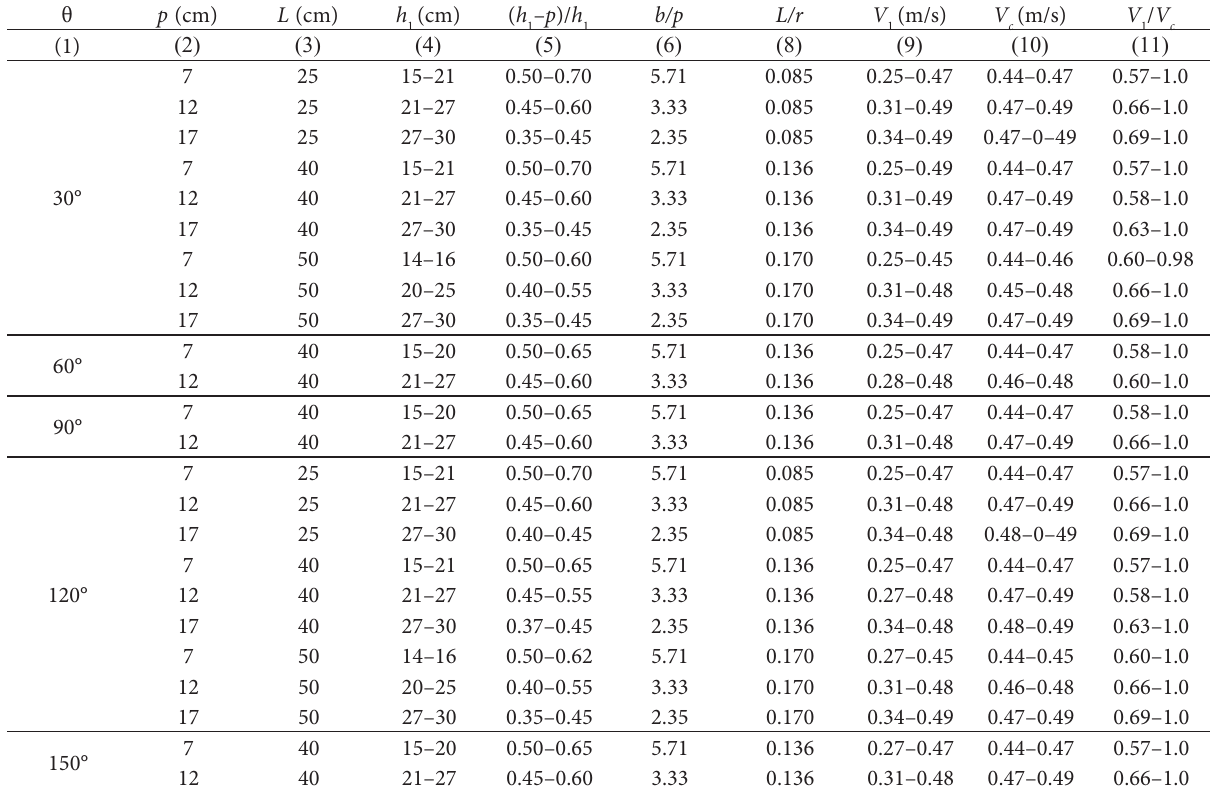
Fig. 4. Bed topography at a side-weir intersection when V Table 1. The dimensions of side-weirs and the ranges of parameters tested for curved